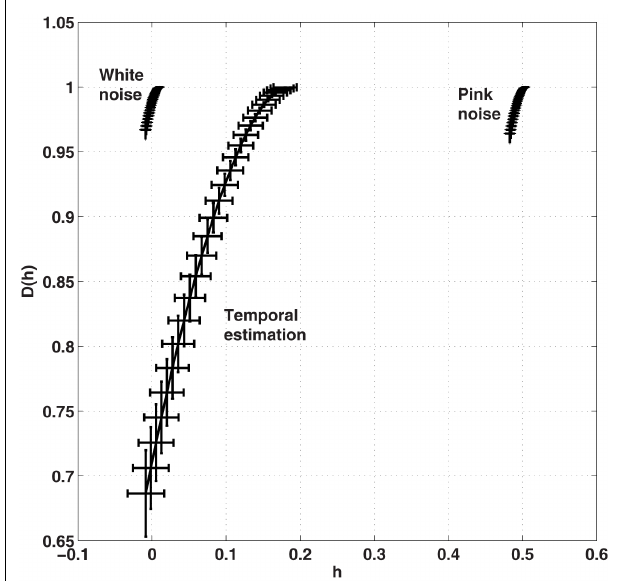
FIGURE 6 |Average multifractal width of the ITIs averaged across all participants and all conditions is presented in Figure 5. Results of the multifractal analysis of the simulated 1/ f noises ( α = 0; white noise and α = 1; pink noise) are provided for a comparison with the multifractal width of the observed time series of ITIs. Horizontal and vertical error bars indicate SE across 30 experimental response series and 30 simulations of each noise process,